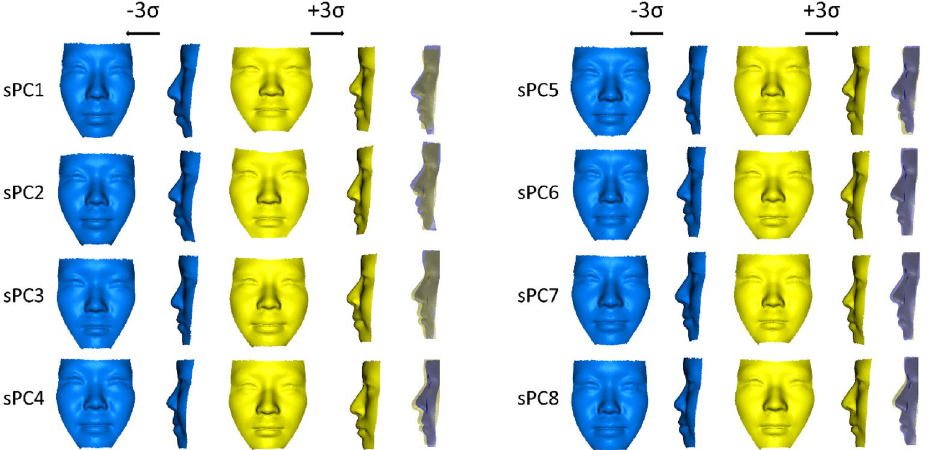
Figure 2. Shape principal components (sPCs) 1–8. Yellow indicates the + 3 standard deviation (σ); blue, − 3 σ. sPCs 1–8 accounted for 70% of the total variation of the faces in the samples. A custom-made MATLAB